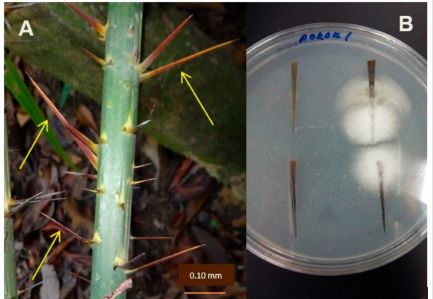
Figure 1. Calamus castaneus spines (yellow arrow) and isolation of endophytic fungi. ( A ) Spines on stem of rattan palm ( C. castaneus ). ( B ) Mycelia growth from the